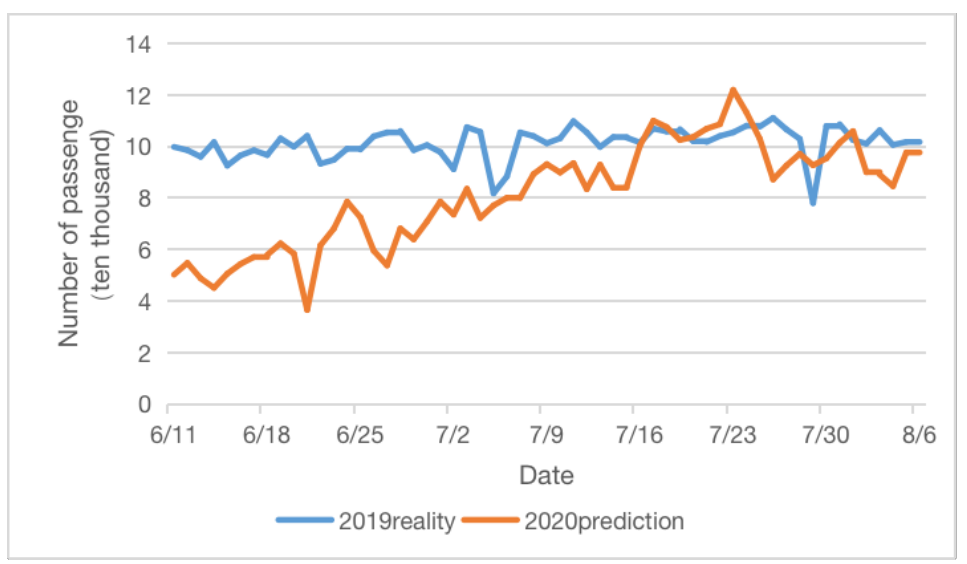
Figure 3. Passenger numbers departing from Beijing (2020 prediction and 2019 reality).